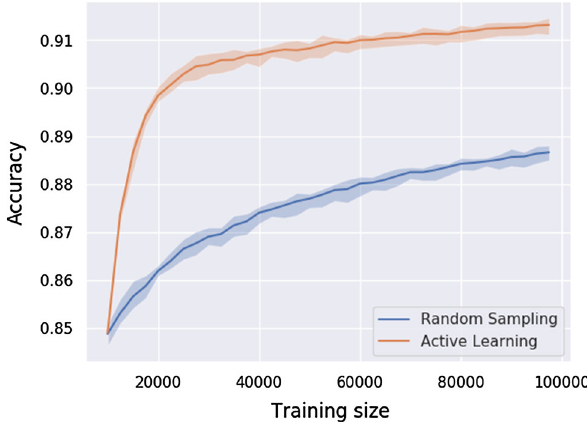
Fig. 3 Accuracy development on model exclusion of the 19- dimensional model for new physics (pMSSM) for random sampling and active learning using a random forest as algorithm and a finite pool. True labeling was provided by ATLAS [1]. Active learning quickly starts outperforming the random sampling. The decline in accuracy for active learning, starting from a training size of 60,000, is caused by the limited size of the pool and the fact that the region around the pool is depleted from data around the decision boundary. The bands around the curves show the range in which all curves of that colour lie when the experiment was repeated 7 times